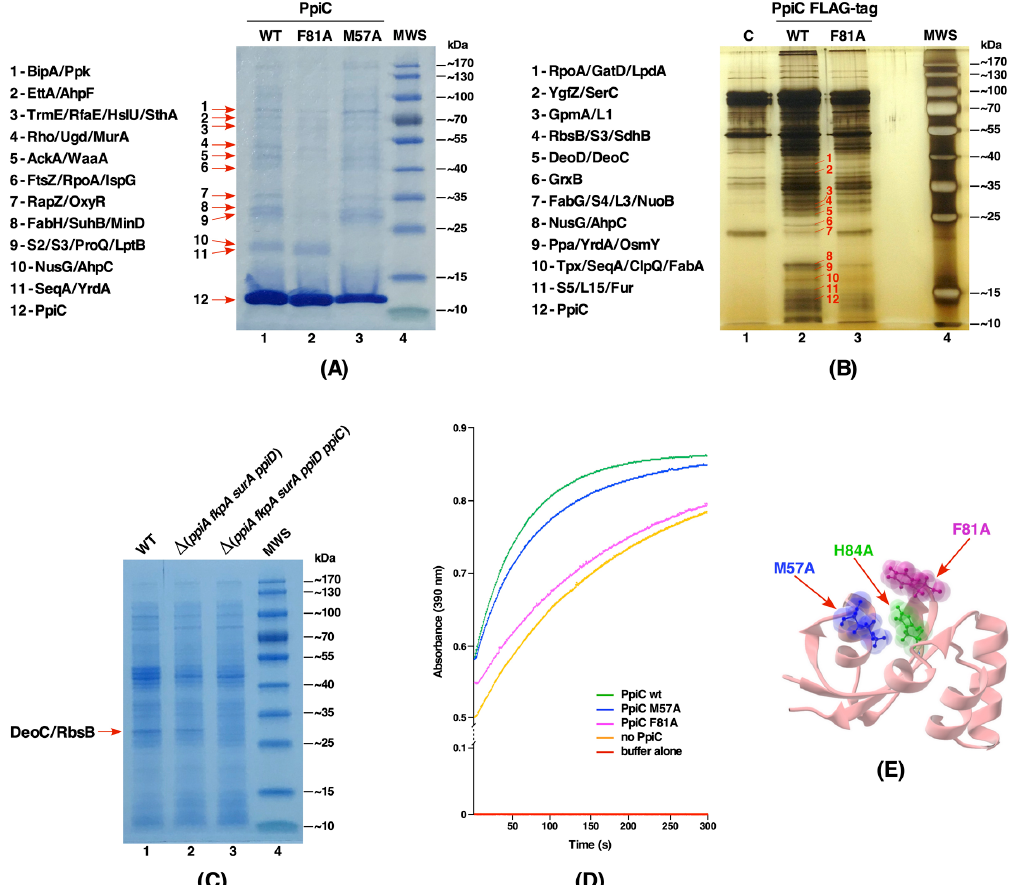
Figure 4. ( A ) Purification profile of wild ‐ type PpiC, PpiC F81A and PpiC M57A after the induction in